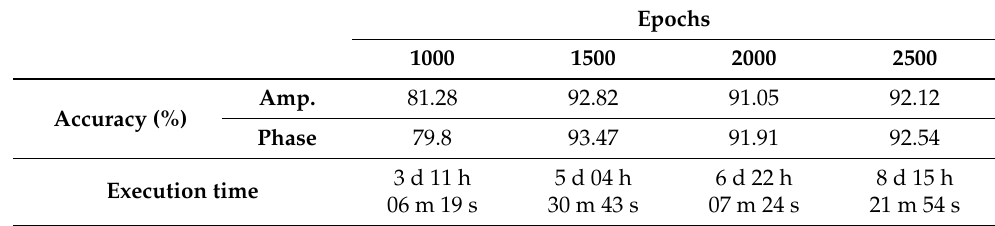
Table 9. Training results for excited signal prediction regression network using sampling line data (6000 test data, pre-trained network: